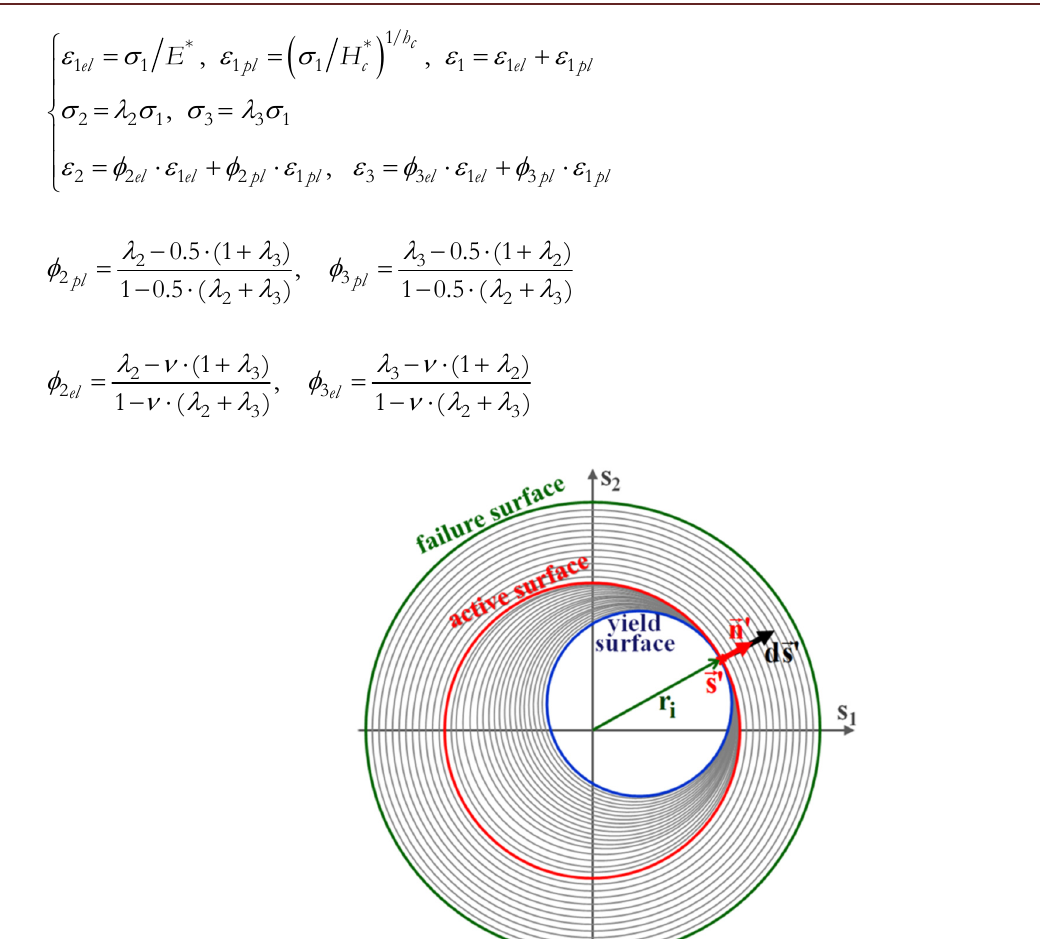
Figure 1: Mróz infinite-surface hardening model for a monotonic proportional